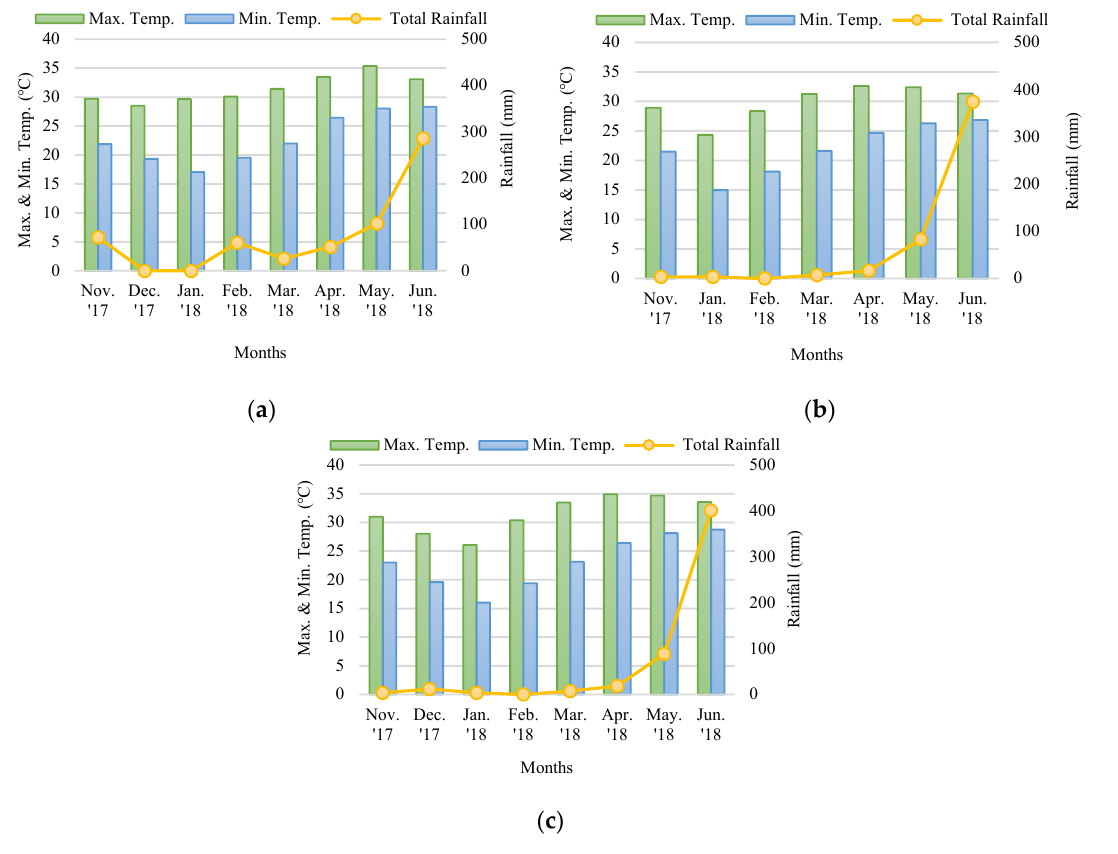
Figure 1. The climate of the study sites ( a ) Senbag, ( b ) Fulgazi, ( c ) Mirsarai during November 2017– June 2018. Table 1. Nutrient analysis of soil at 0–15 cm depth.